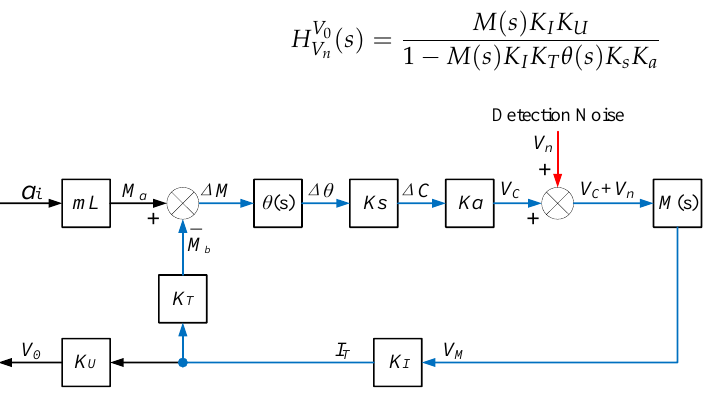
Figure 6. The introduction position of detection noise in the closed-loop system.